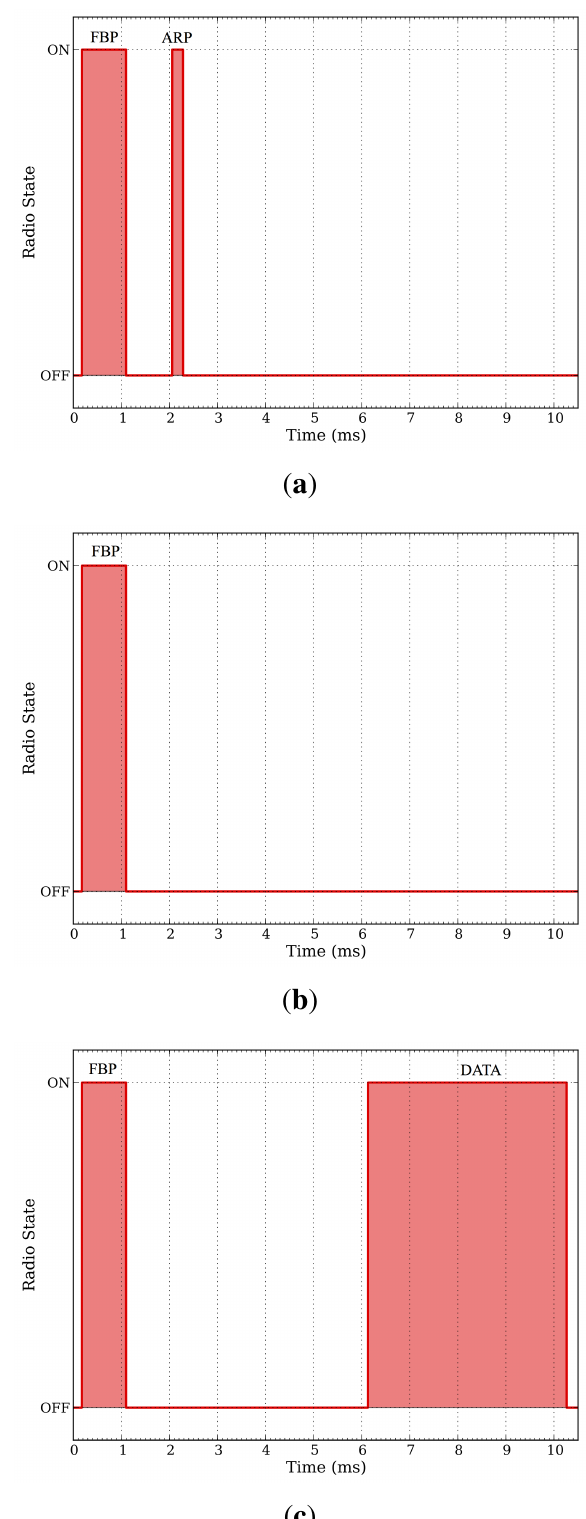
Figure 8. Distributed Queuing (DQ) states and radio activity. The total slot length is 11.9 ms, yielding an overall of 84 packets per second. In DQ the duration of all the states is the same ( 11 . 9 ms). ( a ) ARP_TRANSMIT , OFF = 10.6 ms, RX = 1 ms, TX = 300 µ s; ( b ) CRQ_WAIT and DTQ_WAIT . OFF = 10.9 ms, RX = 1 ms; ( c ) DATA_TRANSMIT . OFF = 6.8 µ s, RX = 1 ms, TX = 4.1